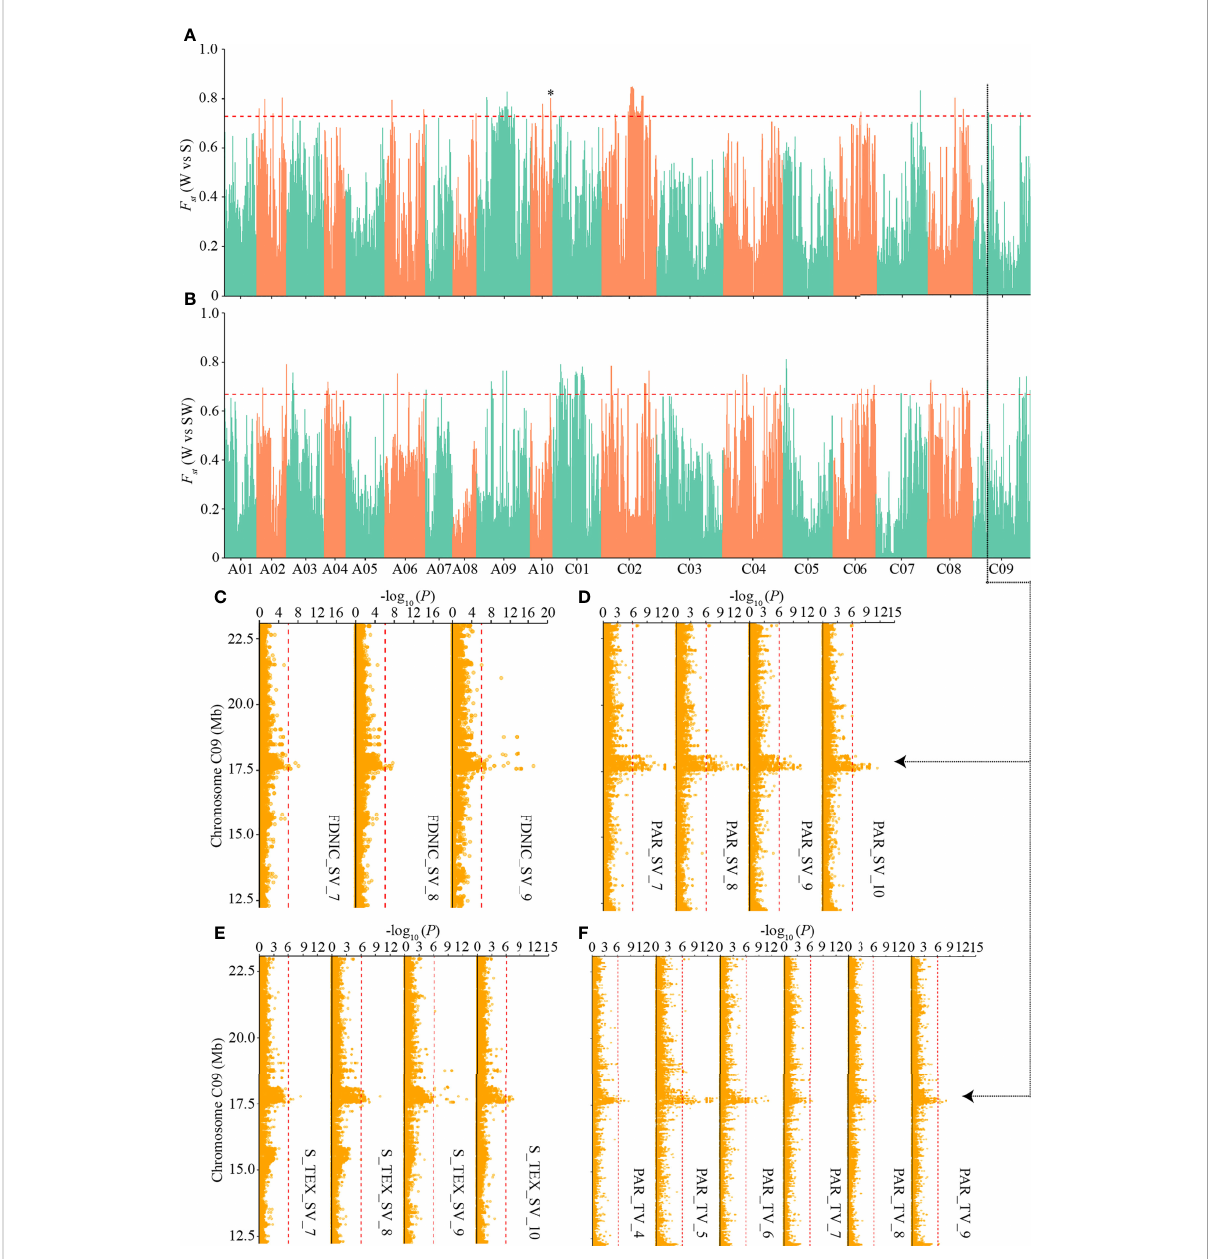
FIGURE 6 Genome-wide ecotype divergence with integration of multiple GWAS signals responsible for the differentiated i-traits. (A, B) Highly divergent regions between the winter and spring ecotypes (A) and winter and semi-winter ecotypes (B) . The horizontal red dashed lines indicate the thresholds (top 1% of F ST values). Region indicated by the asterisk was that surrounding BnaA10.FLC . (C-F) GWAS signals responsible for FDNIC_SV (C) , PAR_SV (D) , S_TEX_SV (E) , and PAR_TV (F) across multiple time points, which overlapped the common divergent regions on C09 chromosome between winter and spring/semi-winter ecotypes. The red vertical dashed lines in Manhattan plots indicate the threshold of GWAS (-log ( P value) =